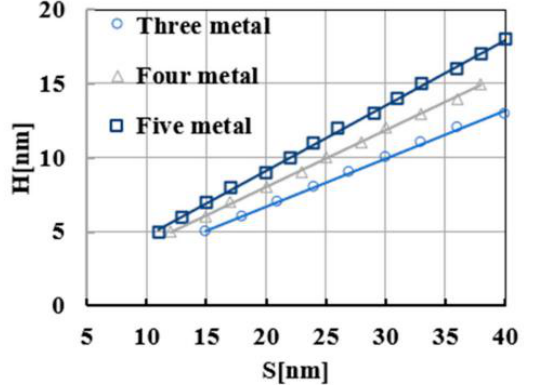
Figure 7. Boundary conditions on the S - H plane for the memory with three, four, and five metal